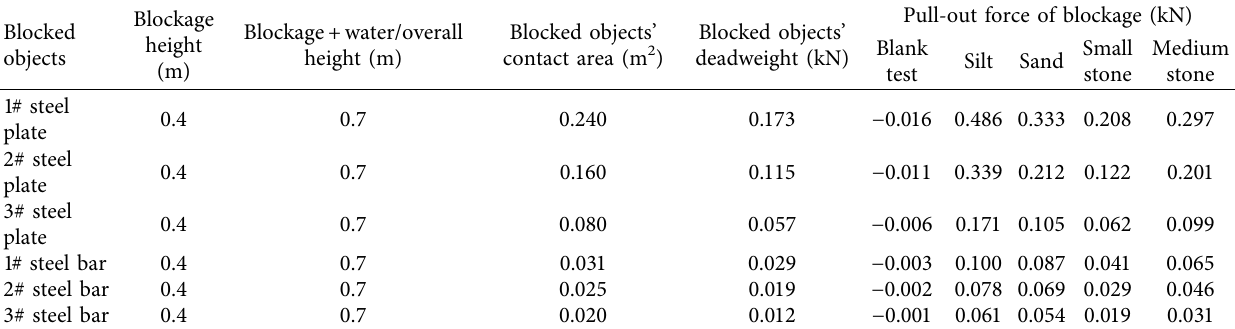
Table 5: Test results of pull-out force of underwater blockage